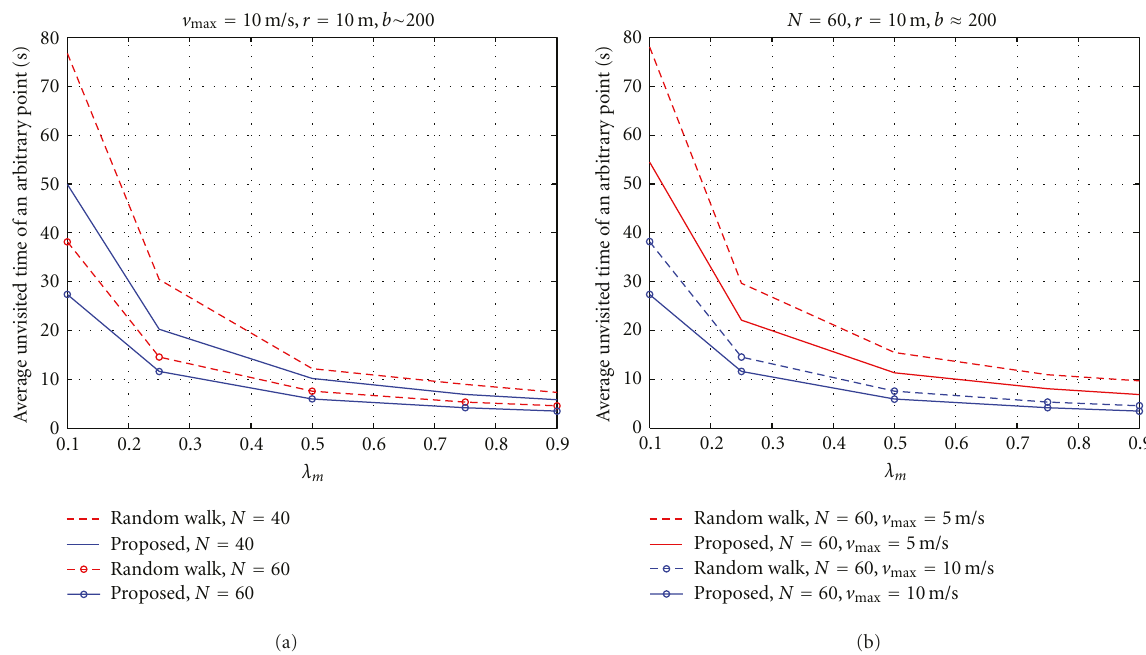
Figure 13: (a) Average time taken for an arbitrary point to be revisited for di ff erent network sizes N : v max = 10 m/s, r = 10m, b ≈ 200m. (b) Average time taken for an arbitrary point to be revisited for di ff erent node speeds: N = 60, r = 10 m, and b ≈